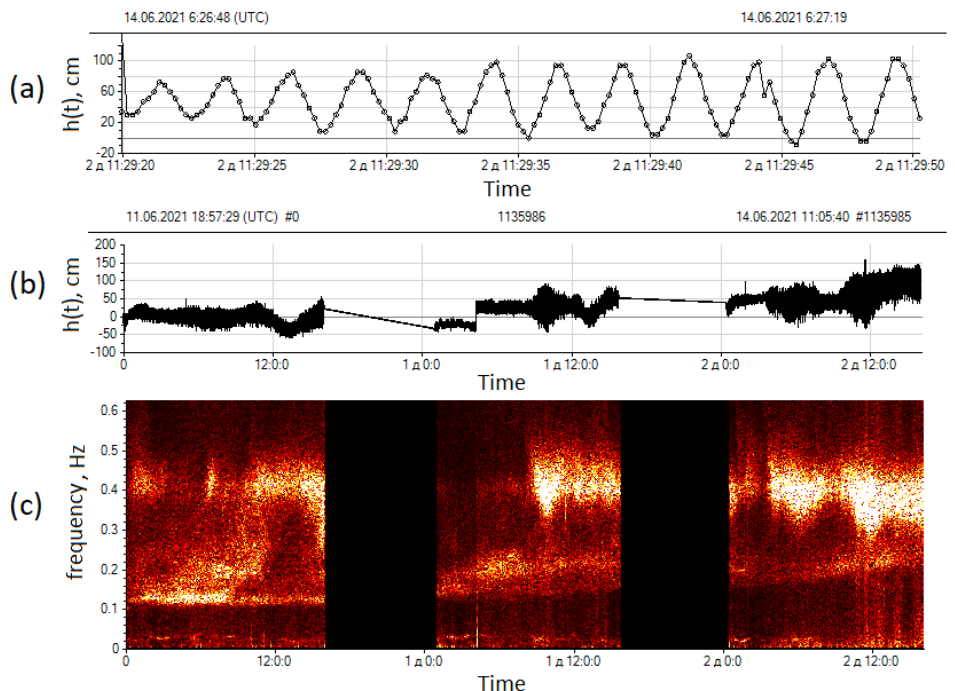
Figure 11. Results of 3-day (11–13 June 2021) measurement of the wave signals in Amurskiy Bay, based on the buoy verticals movement tracking with the Hikvision camera: ( a ) waveform of a 30-s fragment of the wave signal; ( b , c ) waveform and spectrogram of the entire three-day signal,